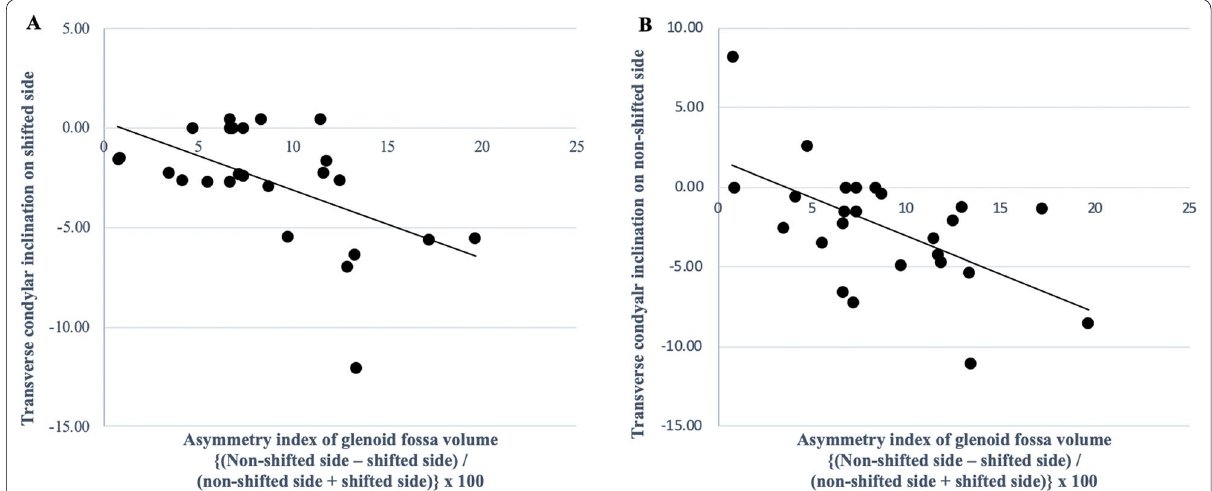
Fig. 7 Simple regression analysis of the asymmetry index of the glenoid fossa volume and the transverse condylar inclination in the mandibular asymmetry group. A : Relationship with the transverse condylar inclination on the shifted side. X ‑axis, asymmetry index of the glenoid fossa volume; Y ‑axis, transverse condylar inclination on the shifted side. B : Relationship with the transverse condylar inclination on the non‑shifted side. X ‑axis, asymmetry index of the glenoid fossa volume; Y ‑axis, transverse condylar inclination on the non‑shifted side